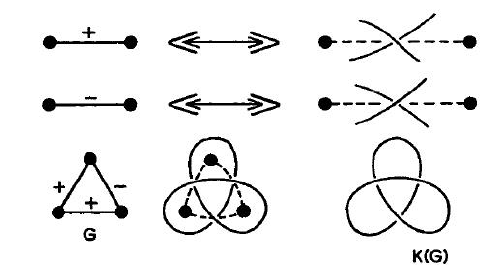
Fig. 1 Link diagram connected with signed